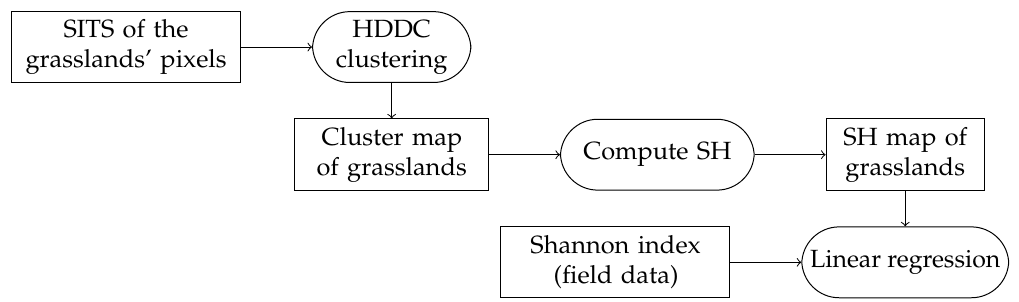
Figure 7. Overview of the method to compare the Spectral Heterogeneity (SH) measures (explanatory variables) to the Shannon index (response variable). Square rectangles correspond to data, and rounded rectangles correspond to a process.